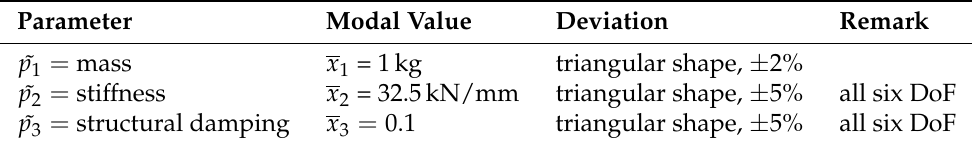
Table 1. Parameter uncertainties.